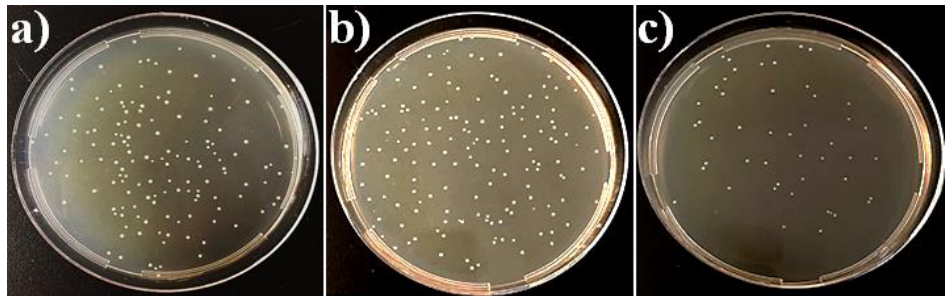
Figure 8. Culture plate photographs of S. aureus after re-cultivation: ( a ) cp-Ti substrate, ( b ) the MAO and ( c ) Cu-based MAO surface cultivation.